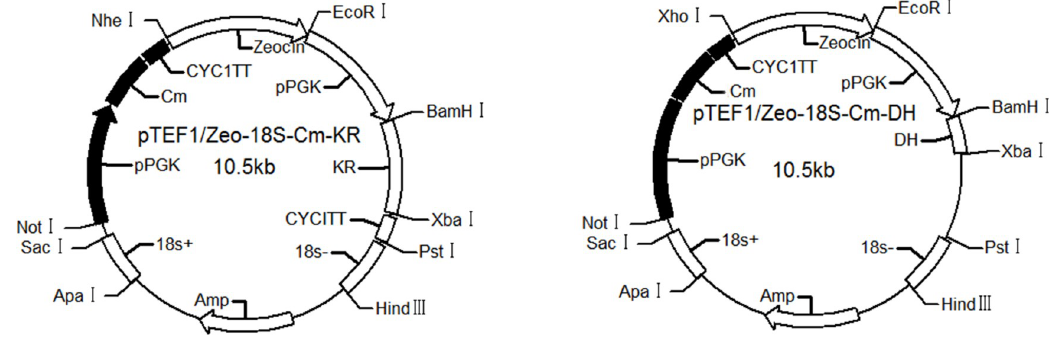
Fig 4. The structure of gene knock-in